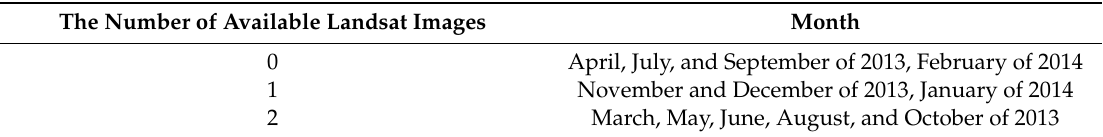
Figure 14. The distribution of monthly “Landsat-like” LSTs in 2013.